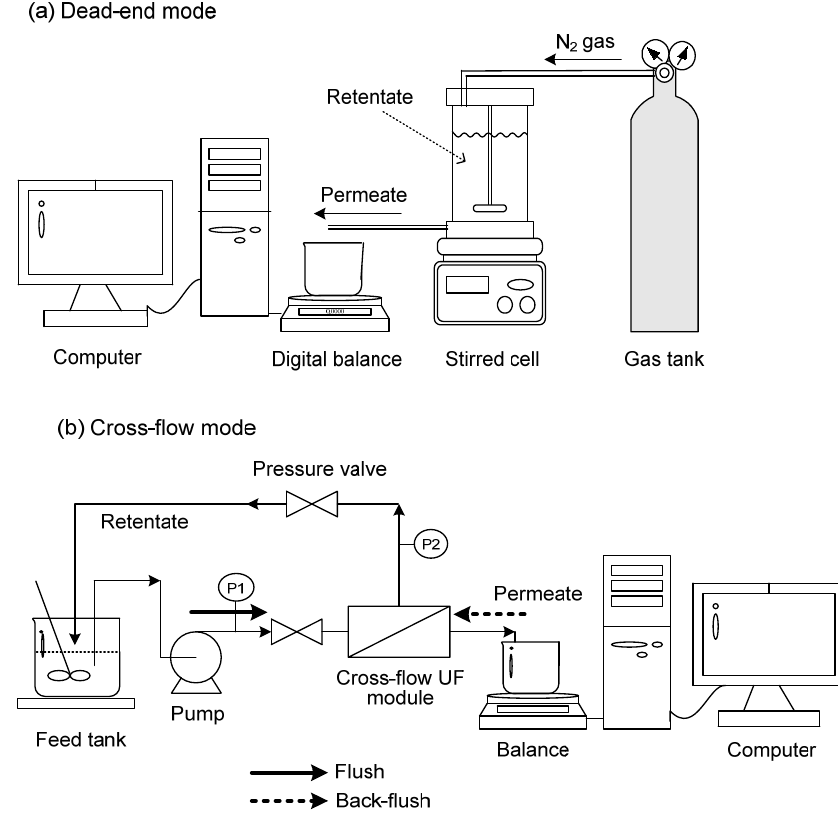
Figure 1. Schematic experimental setup for UF in ( a ) dead-end and ( b ) cross-flow modes.